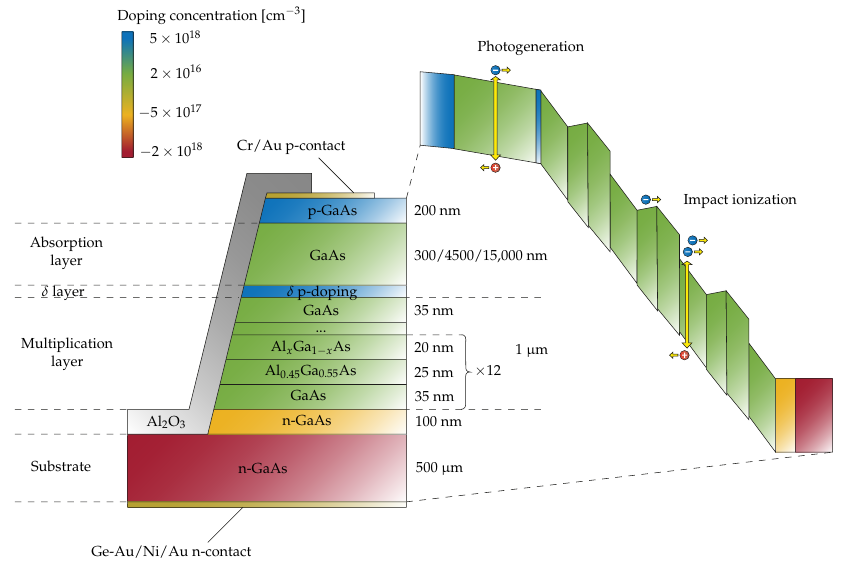
Figure 1. Sketch of the GaAs APD considered in this work (not to scale). The grown layered structure is depicted on the left side, where the layer colour represents its doping concentration. On the right side, there is a corresponding band diagram under the reverse bias.